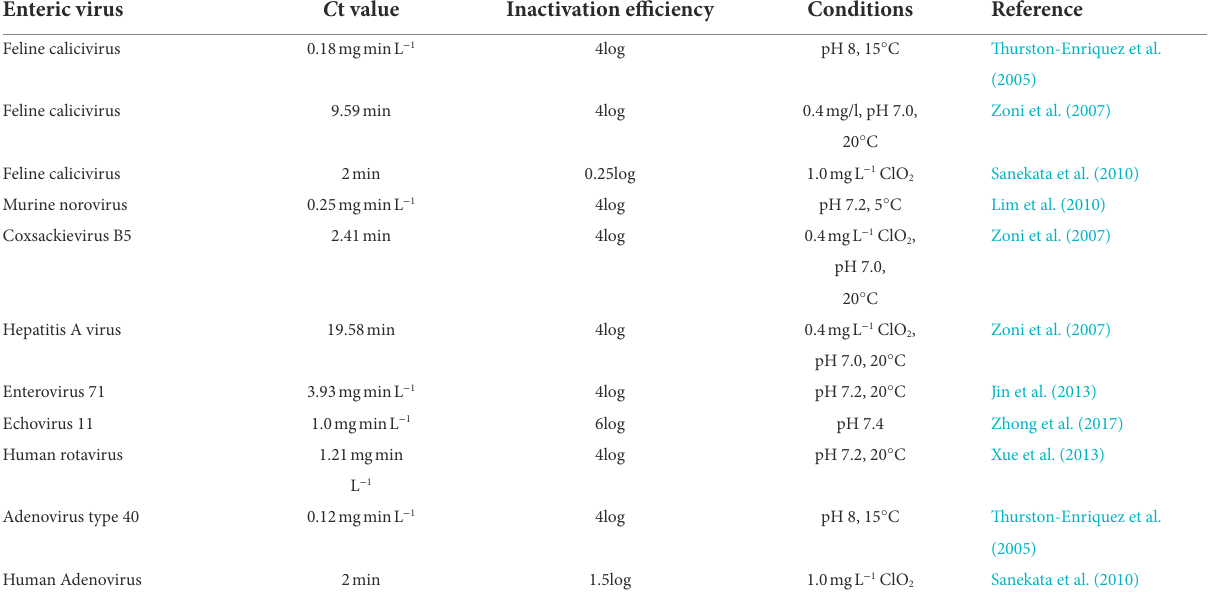
TABLE 2 Inactivation efficiency of selected viruses by chlorine